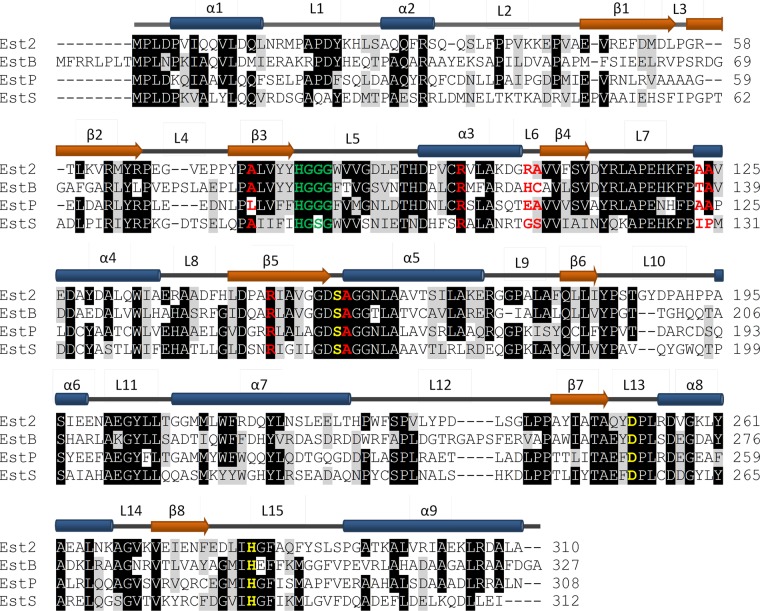
Structure-based sequence alignment of esterase Est2 from the thermophilic bacterium A. acidocaldarius with esterases EstB from mesophilic B. hailandensis, EstP from psychrotrophic Pseudomonas sp. B11-1, and EstS from psychrophilic S. halifaxensis. Notably, loops show lower sequence similarity when compared with the other regions. Sequences identical and similar in at least three residues were shaded in black and gray, respectively. The catalytic triad residues Ser, Asp and His are colored in yellow and the oxyanion hole residues in green. Residues colored in red follow the traffic rule reported for Est2 (Mandrich et al., 2009). Secondary structural elements of Est2 are shown above the alignment with α-helices as blue cylinders, β-strands as red arrows, and loops as gray lines, respectively (De Simone et al., 2000).